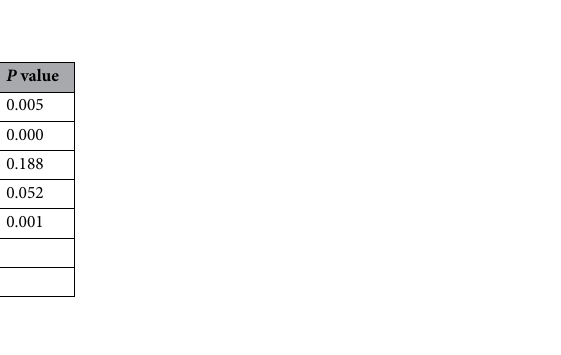
Figure 4. Graphical plot for the interaction between admix of kenaf fiber (KF)/particulate snail shell (PSS) at varying proportion and ( a ) hardness ( b ) impact strength.